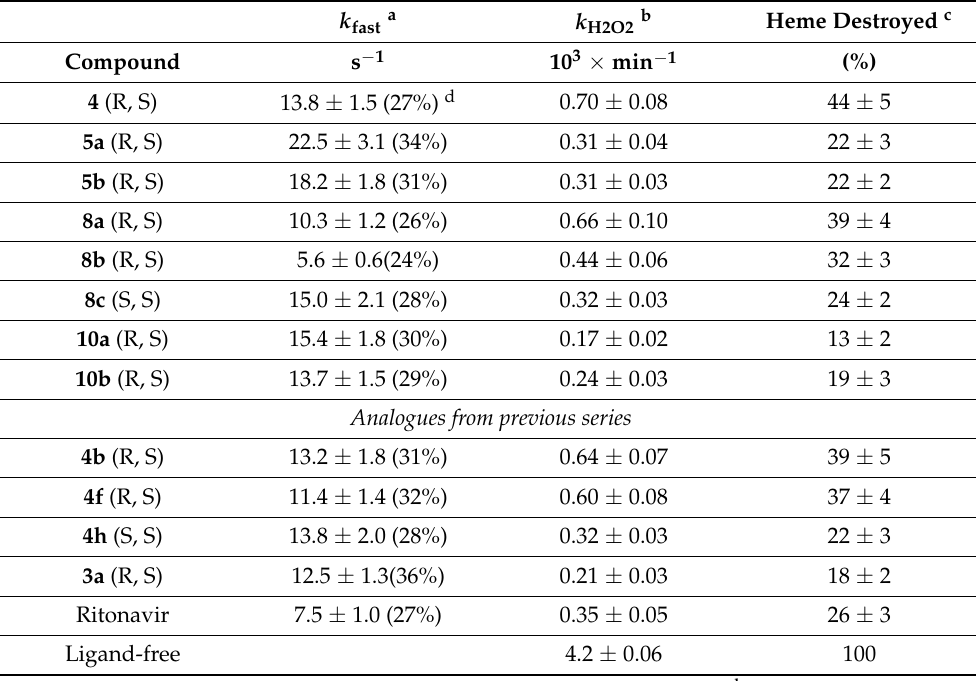
Table 2. Parameters for the ligand-binding and heme-bleaching kinetics. k fast a k H2O2 b Heme Destroyed c Compound s −